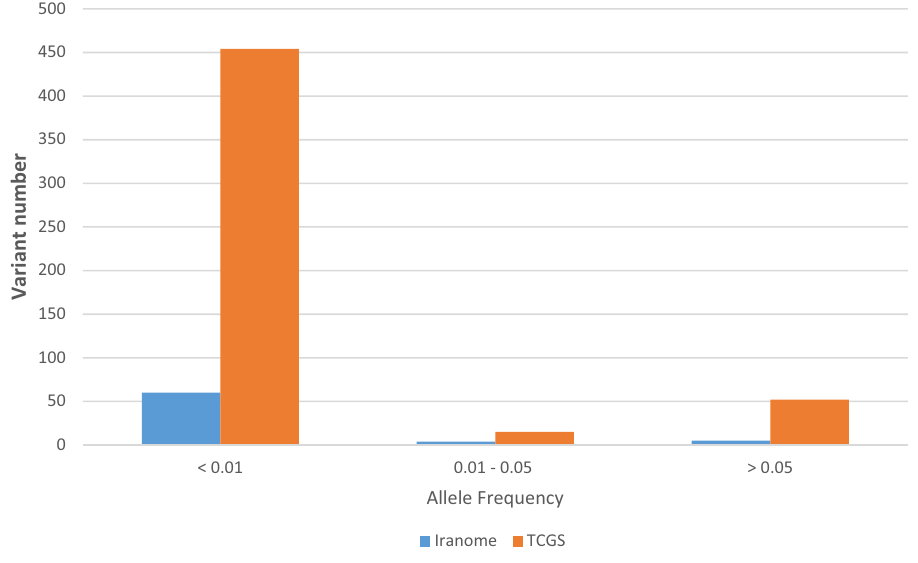
Figure 1. Allele frequency spectrum of ACE2 variations within the Iranian population (TCGS and Iranome